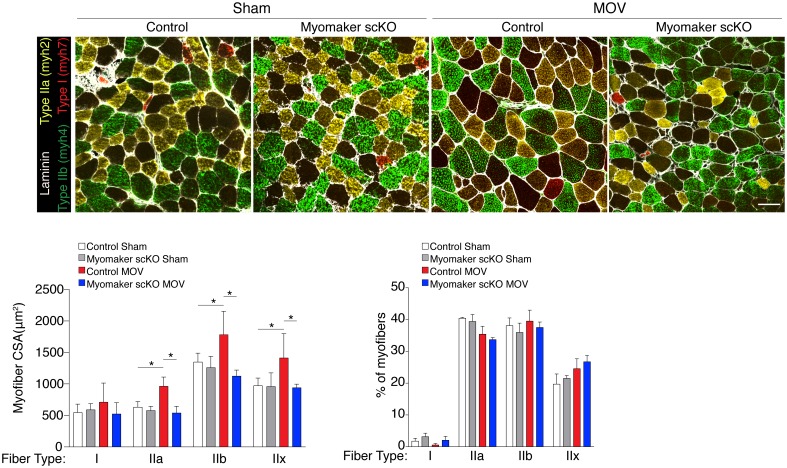
All fiber types fail to hypertrophy in myomaker scKO muscle after MOV.Representative plantaris sections immunostained with antibodies for laminin, myh7 (Type I myosin, red), myh2 (Type IIa, yellow), and myh4 (Type IIb, green). Type IIx fibers are unstained. Quantification of fiber type cross-sectional area at the plantaris mid-belly reveals a significant increase in Types IIa, IIb, and IIx myofiber size in control mice after overload, whereas myofiber hypertrophy in each of these fiber types is significantly inhibited with satellite cell ablation of myomaker (n = 28–54 fibers (Type I) or 500–1,900 fibers (Types IIa, IIb, IIx) from 3–5 independent mice). Frequency distribution analysis reveals that fiber type composition remains relatively unaltered after 14 days of MOV (n = 1100–1,700 fibers from three independent mice). Data are represented as mean ± SEM, *p<0.05. Scale bar: 50 μm.